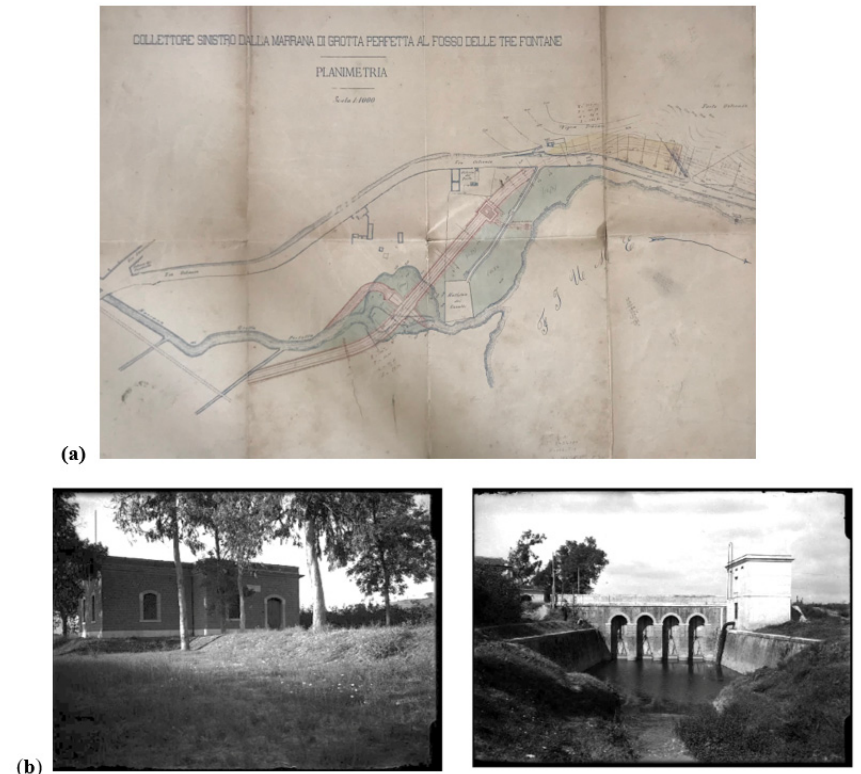
Figure 4. ( a ) Collector sewer path general plan between the Marana di Grotta Perfetta and the Tre Fon- tane ditch, 1882; ( b ) picture of the Collector sewer point of disposal n. 7 and of the sewer crossing of the Marana watercourse, 1925–27 (courtesy of Rome State Archive, Ufficio Speciale per il Tevere e l’Agro Romano